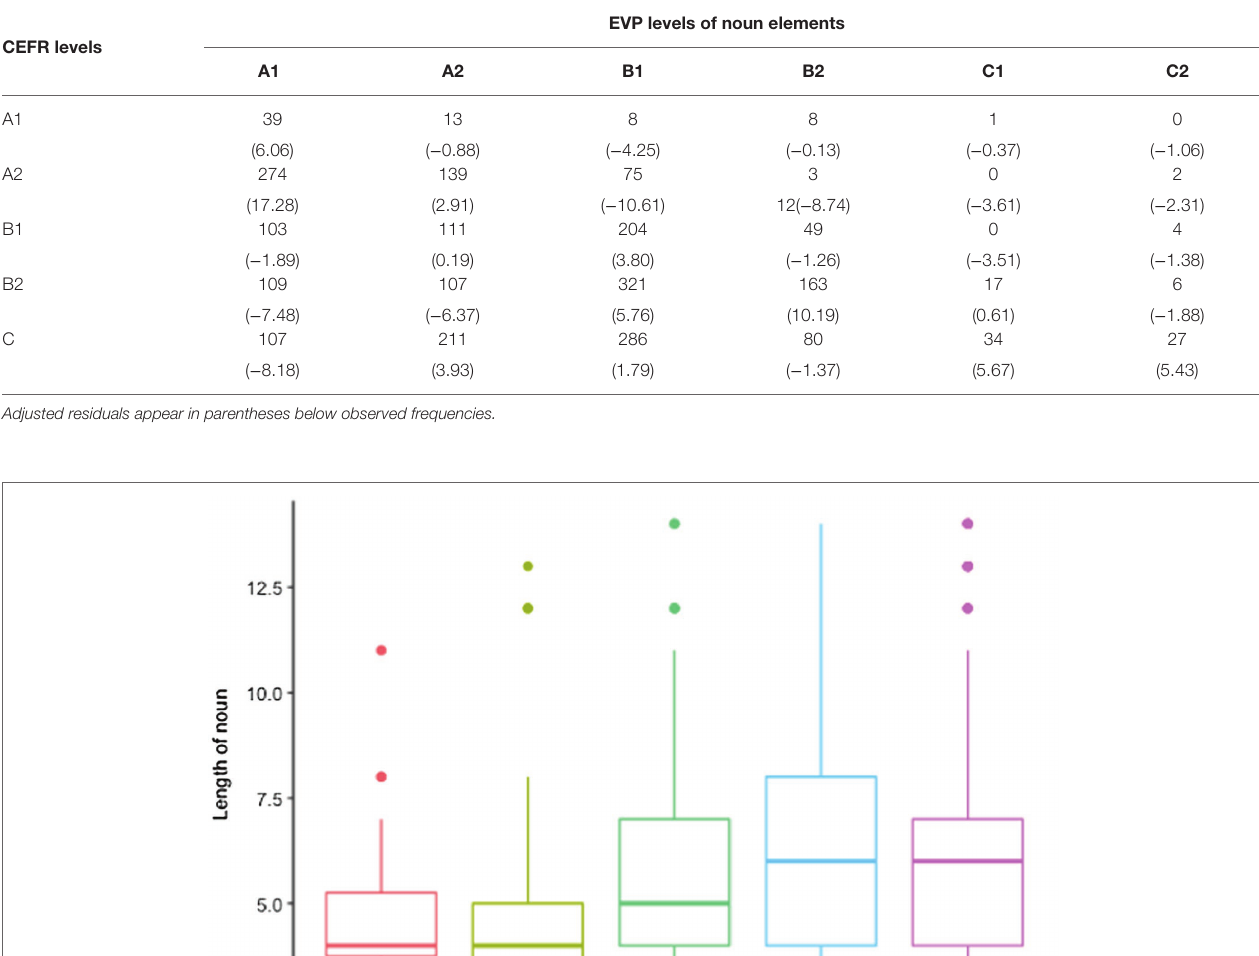
EVP levels of noun elements